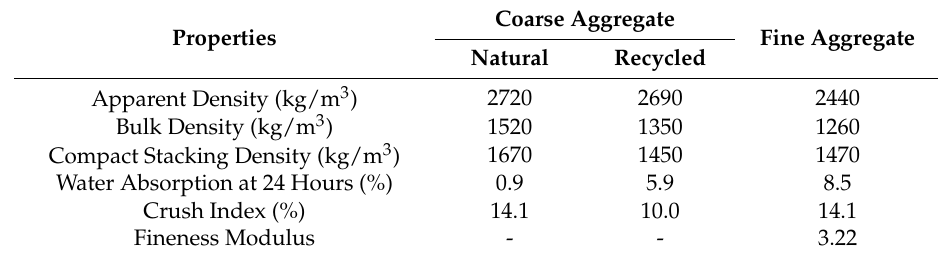
Table 2. The physical and mechanical properties of